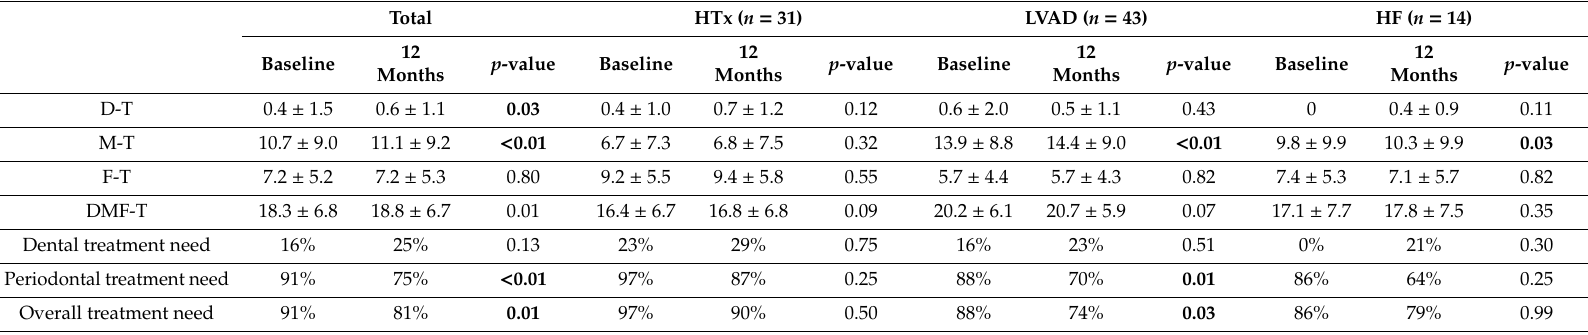
Table 4. Results of the dental examination in the total cohort and between groups at baseline and follow-up, significance level: p <